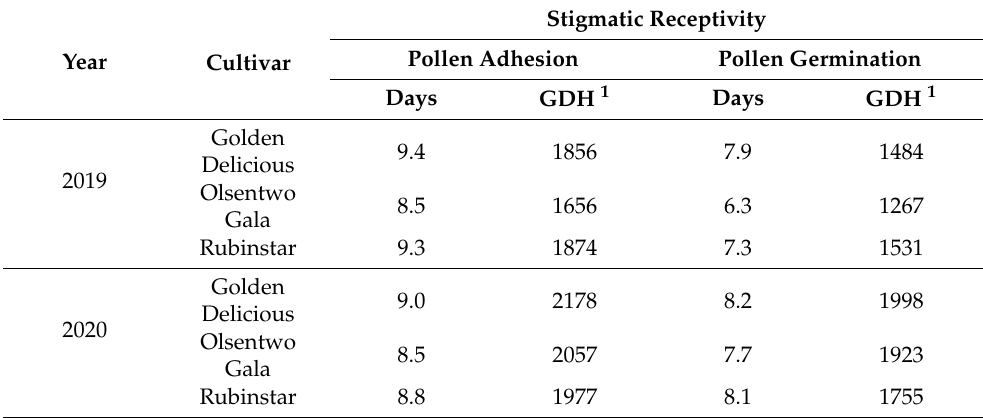
Table 1. Duration of stigmatic receptivity based on pollen adhesion and pollen germination of ‘Golden Delicious’, ‘Olsentwo Gala’, and ‘Rubinstar’ flowers in 2019 and 2020.